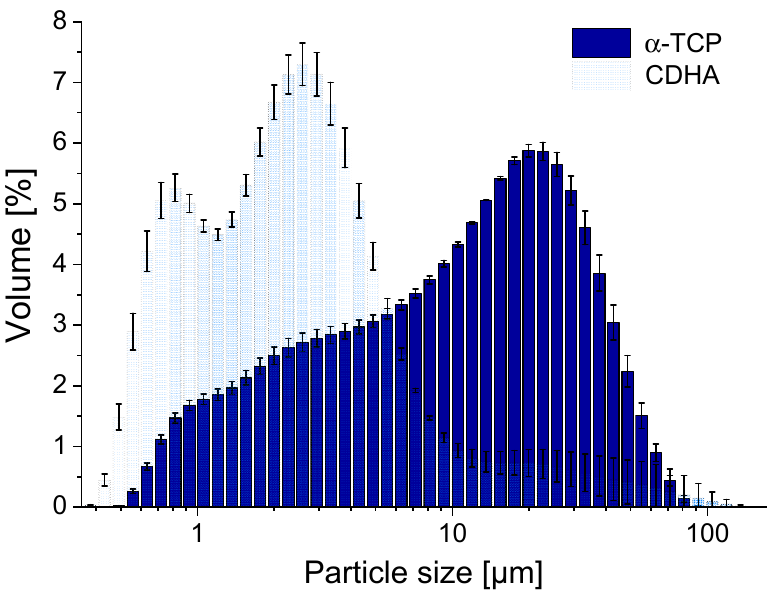
Table 1. D V values obtained by laser diffraction and BET surface areas of α –TCP and CDHA; the values are the means of three independent preparations, while for the laser diffraction ten measurement runs were performed for each preparation; the errors represent the standard deviations of the three preparations.